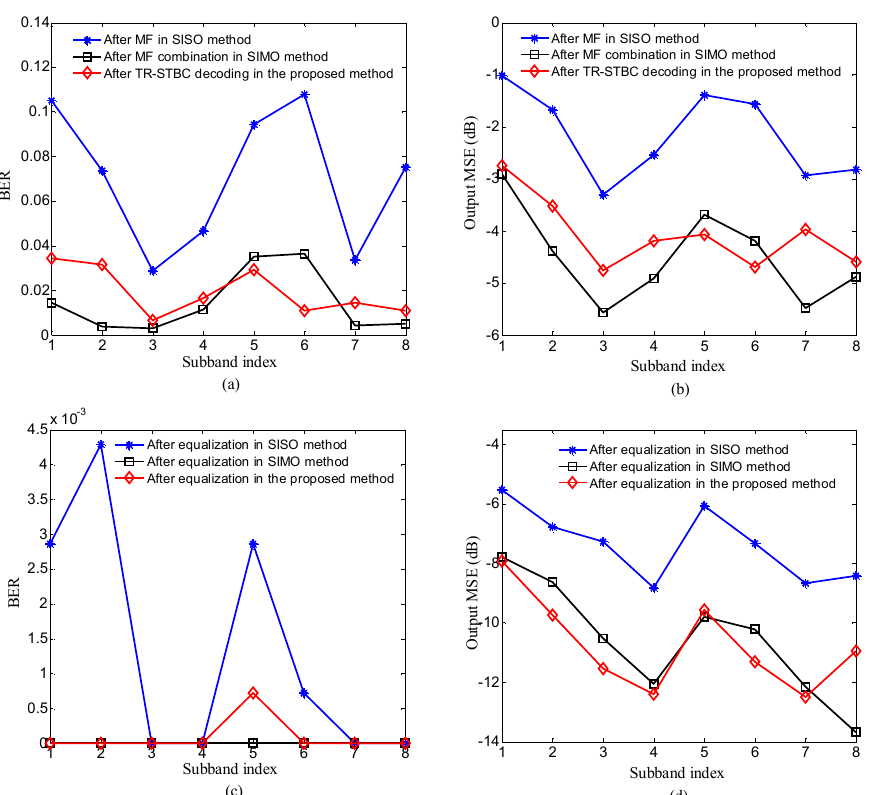
Figure 11. Comparison of the performance for each sub-band among three methods: ( a ) and ( b ) comparing the BER and output MSE after three processing scenarios consisting of TR-STBC decoding in the proposed method, MF in the SISO method and MF combination in the SIMO method; ( c ) and ( d ) comparing the BER and MMSE after adaptive equalization among the three methods.